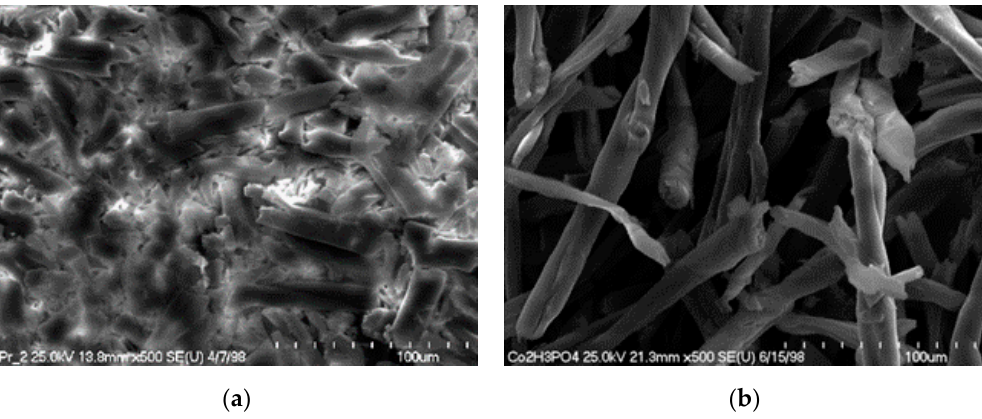
Figure 15. SEM pictures of the solid residue after hydrolysis (140 °C; 2 h), depending on the type of acid used: ( a ) cotton treated 2% H 2 SO 4 ; ( b ) cotton treated 2% H 3 PO 4 .